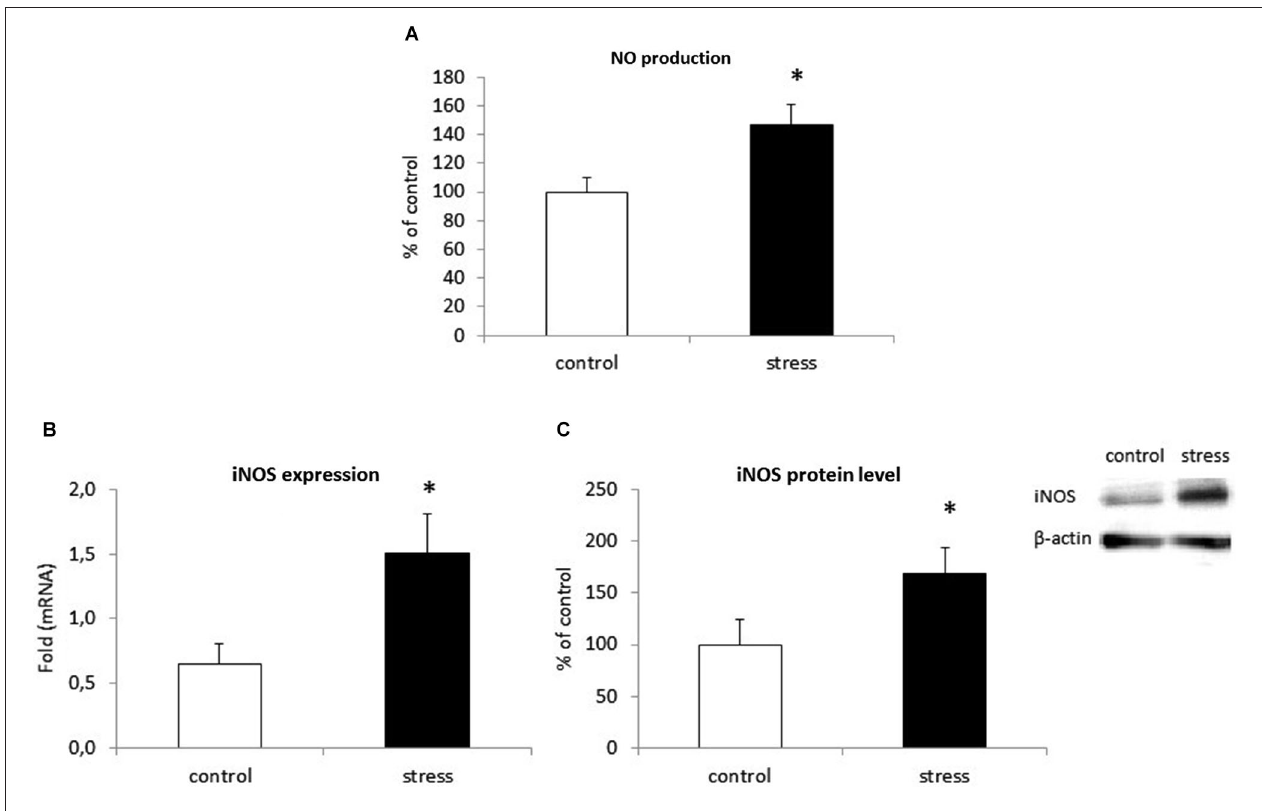
as average fold ± SD. The results from western blot analyses are normalized with β -actin and presented as % of control ± SD from 3 independent experiments ( n = 6 in each group); * p < 0.05; one-way ANOVA.